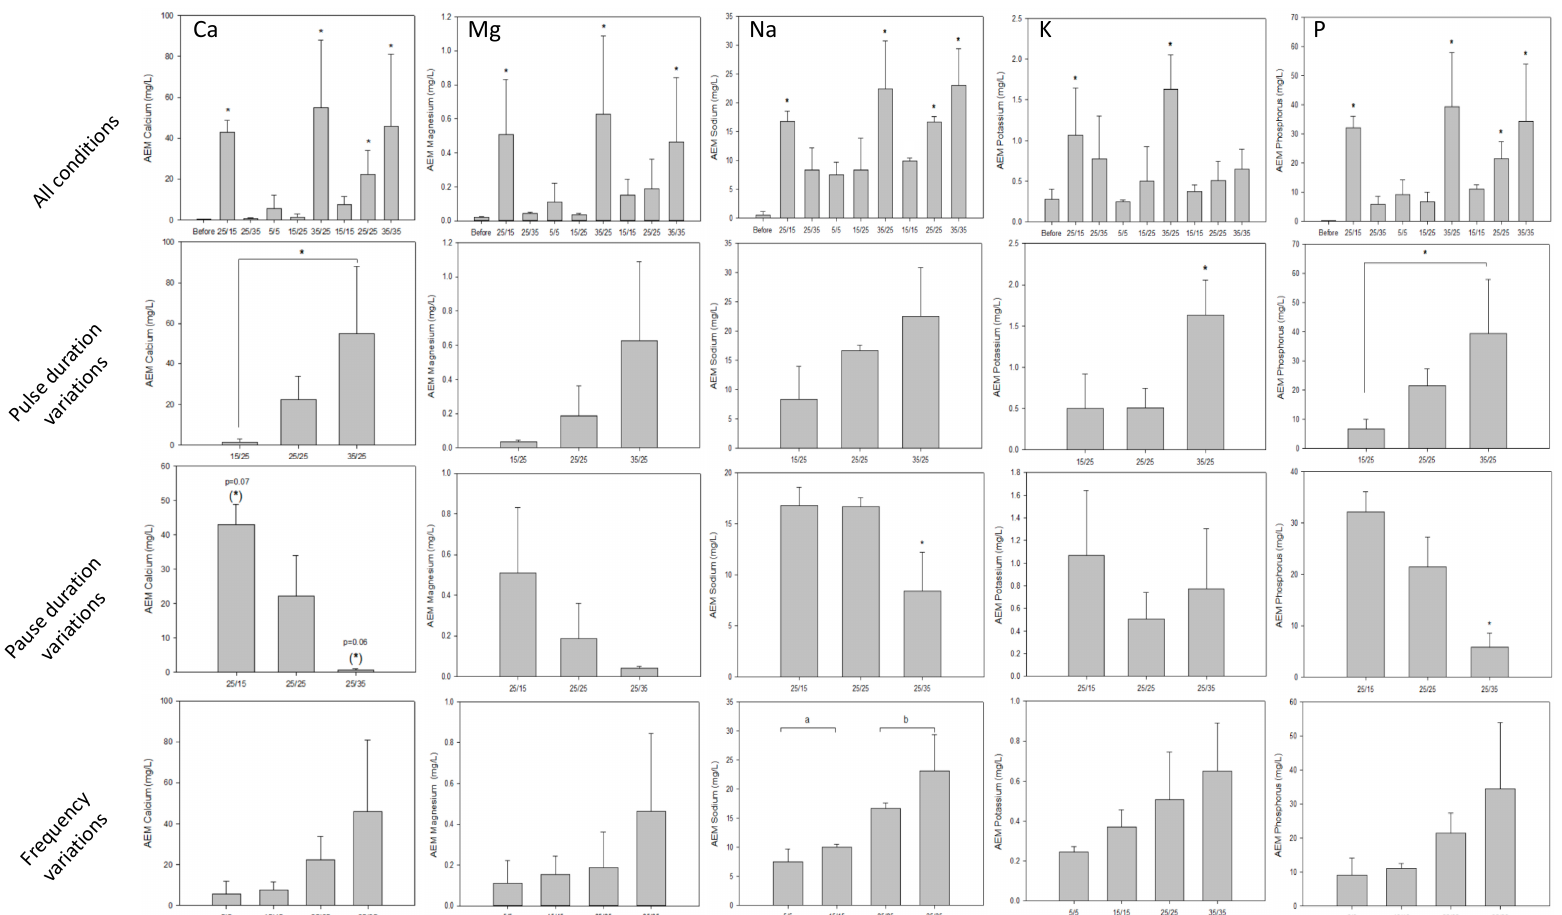
Figure 11. AEMs mineral content for all PEF conditions tested. ICP measurement was conducted after each ED run for calcium, magnesium, sodium, potassium, and phosphorus and compared to the content of pristine membranes or other conditions membrane. For all conditions, * there is a statistical difference between these values and that of the pristine membrane (P < 0.05 with Dunnett test). For the parameter variations on rows, * or different letters on histograms means there is statistical difference between their value and the others (P < 0.05 with Tukey test).